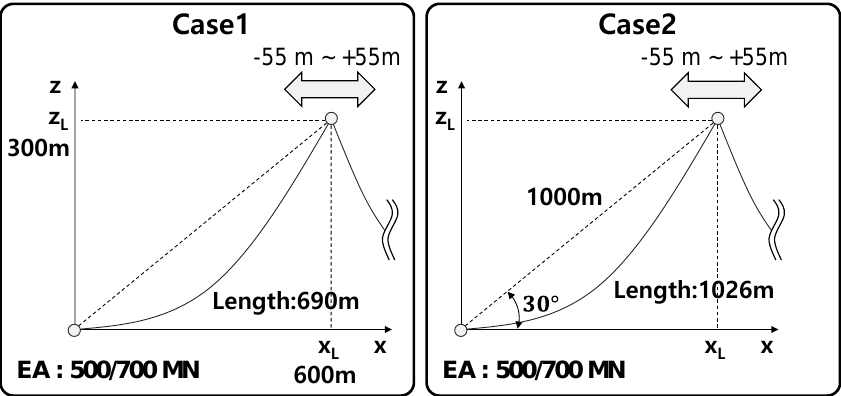
Figure 12. Conditions of the first simulation for forced oscillation body with two mooring lines. Figure 13 shows the calculated restoring force. The solid line represents the simulation results obtained using the analysis module developed in this study, while the dotted line represents the simulation results obtained using Orcaflex. It can be observed that the simulation results are almost the same.